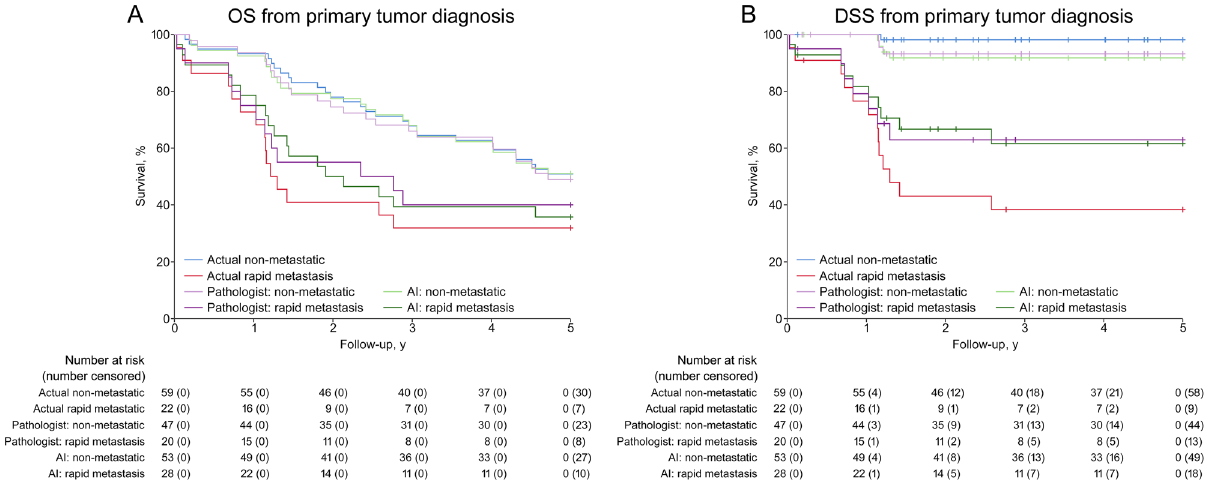
Figure 2. Kaplan–Meier overall survival (OS) and disease-specific survival (DSS) estimates calculated from the time of initial diagnosis of primary cSCC. ( A ) OS and ( B ) DSS estimates of actual non-metastasis (n = 59) and rapid metastasis (n = 22) cohorts in comparison with cohorts predicted by artificial intelligence (AI) as non-metastatic and rapid metastasis as well as cohorts predicted by pathologist as non-metastatic and rapid